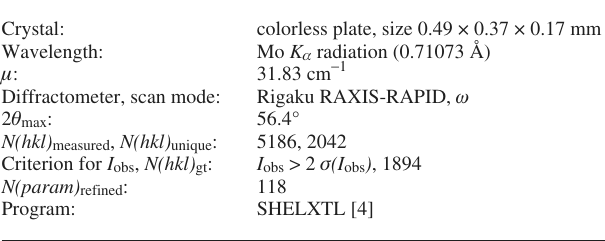
Table 1. Data collection and handling.